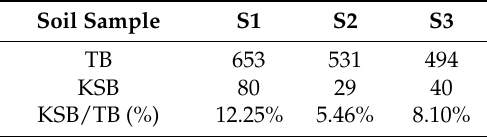
Table 2. Enumeration (bacterial number · g − 1 soil) of total bacteria (TB) and potassium-solubilizing bacteria (KSB) from soils S1, S2, and S3, and the relative abundance of the cellulose-degrading bacteria of each